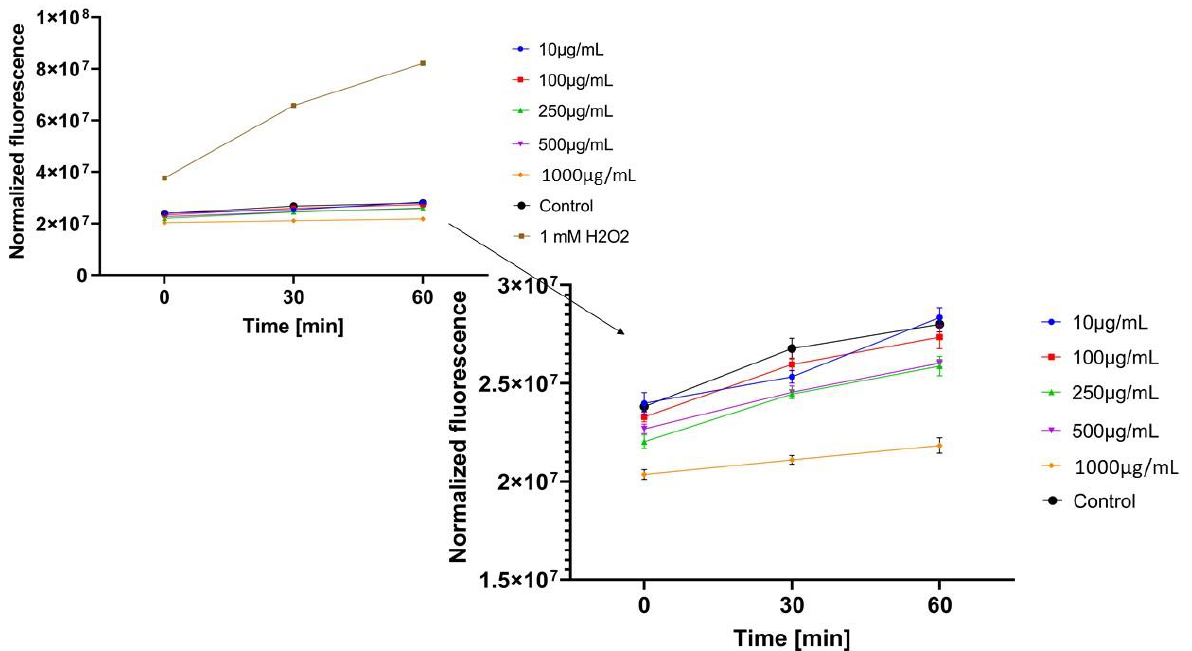
Figure 5. The effect of Clitoria ternatea L. extract on the 2’,7’-dichlorofluorescein (DCF) fluorescence in keratinocyte cells (HaCaT). The data are expressed as the mean±SD of 3 independent experiments, each of which consisted of 3 replicates per treatment group.